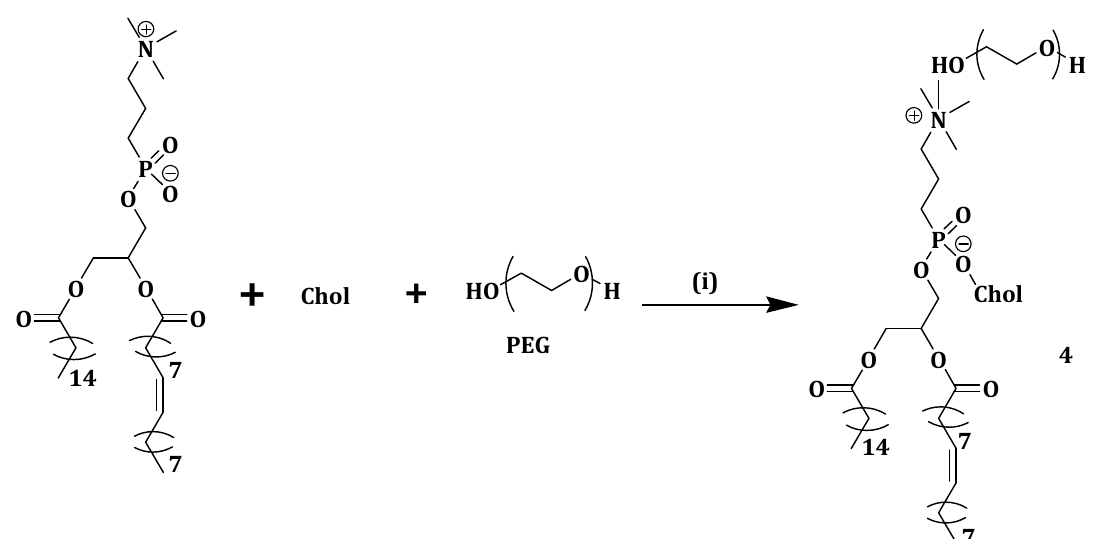
Scheme 2. Synthetic route for liposomes containing lecithin, PEG and cholesterol ( 4 ). Reagents